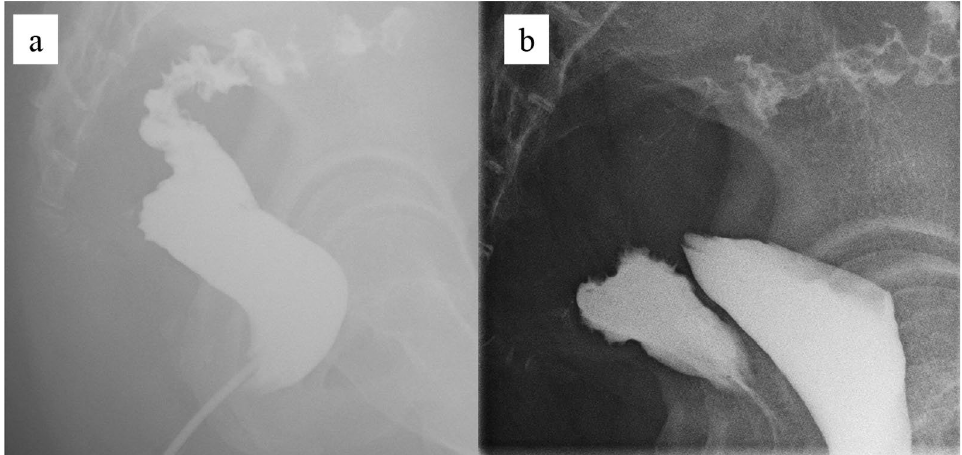
Fig. 4 A Gastrografin enema from the anus. B Gastrografin enema from the vagina. These demonstrated no fistula between the vagina and the